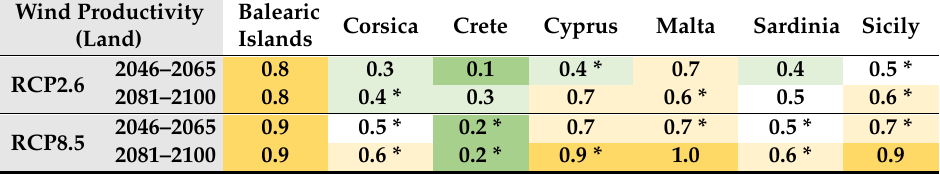
Table 3. Normalized changes (Nc) for wind productivity for each island, scenario and time period. Deep green cells: Nc = 0–0.2; Light green: Nc = 0.3–0.4; White: Nc = 0.5; Light yellow: Nc = 0.6–0.7; Deep yellow: Nc = 0.8–1. Nc and Nu are computed over land. The * indicates the cases in which Nu > 0.5.